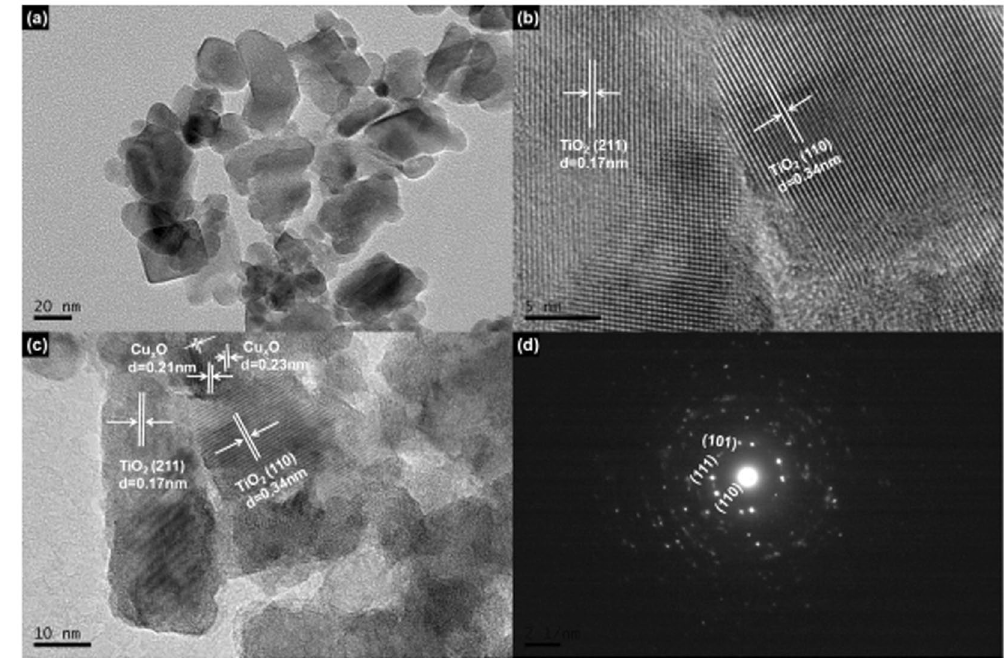
Figure 3. ( a ) TEM images of Cu x O/TiO 2 (S7), ( b ) HRTEM of TiO 2 (S0), ( c ) HRTEM of Cu x O/TiO 2 (S7), and SAED pattern of the same Cu